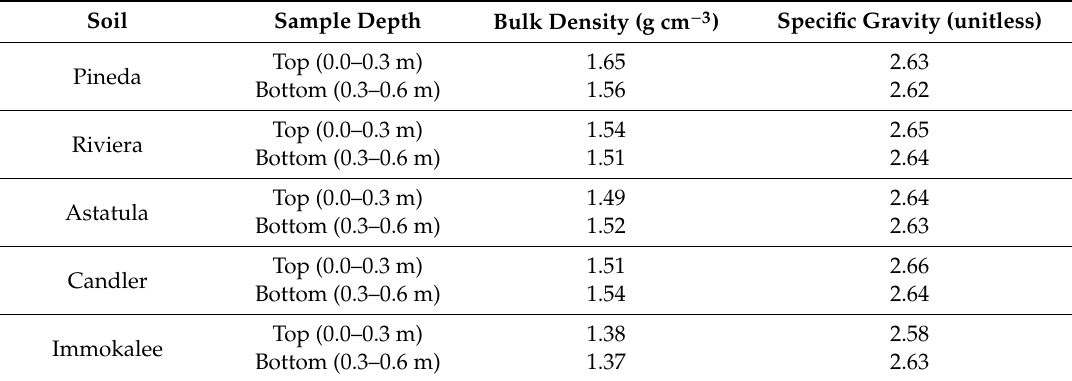
Table 2. Physical properties of soils